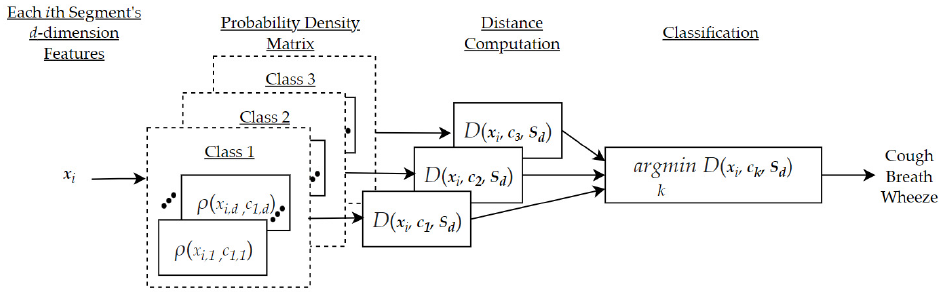
Figure 2. Proposed embedded architecture for the K-MDC classification of the 𝑖 th segment.